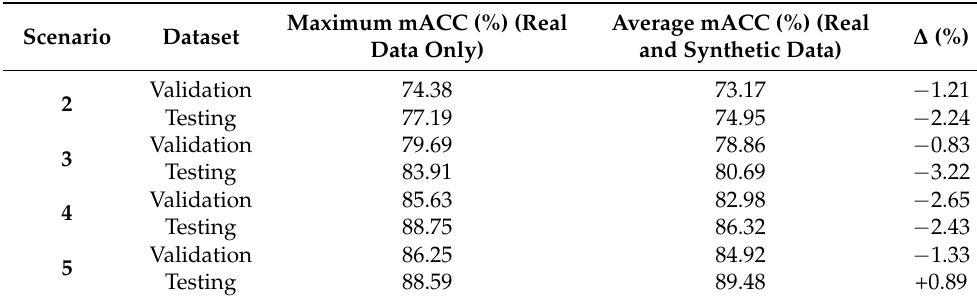
Table 5. Comparison of maximum mACC using real training data and average mACC using synthetic and real training data for validation and testing datasets.